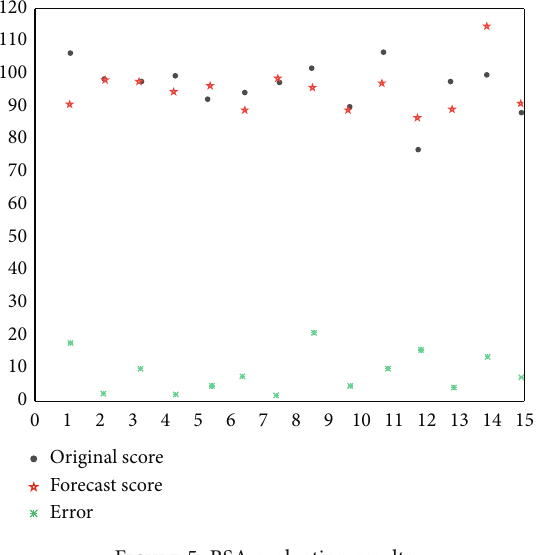
Figure 5: BSA evaluation